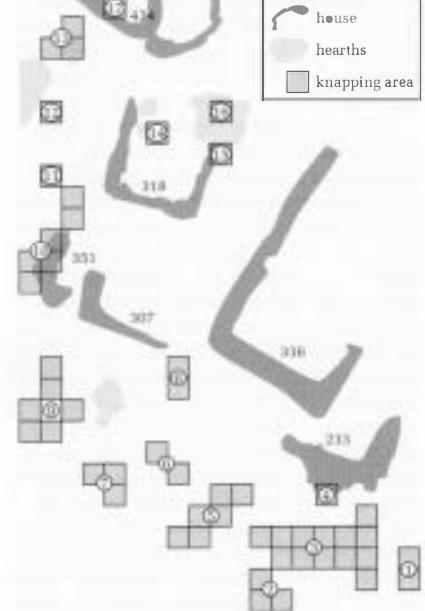
Figure 2 The LBK settlement of Hanau Klein-Auheim (Germany}, showing houses and stone-knapping areas (each unit exca­ vated is 1 m2).